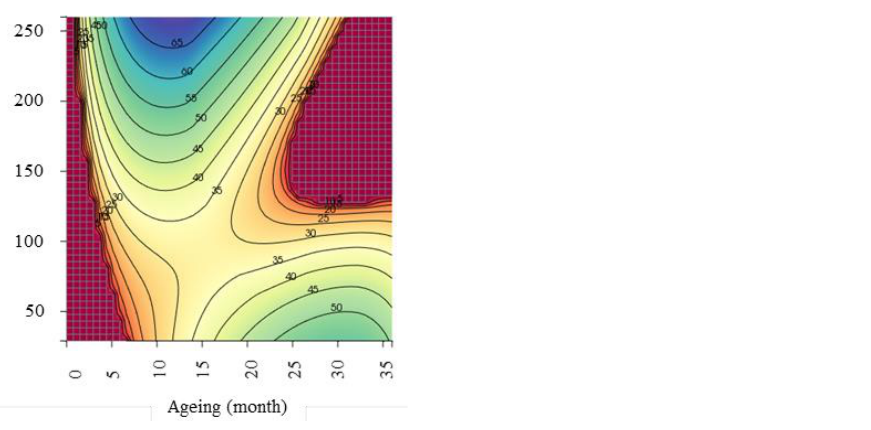
Figure 15. Desirability plots of ageing (months) vs dose (kGy). Contours are in % of desirability. Deep blue colour is for 100% of desirability (all requirements are fulfilled) and red colour is for 0% of desirability (no requirements fulfilled). Reproduced from [42] with the permission of Polymers.